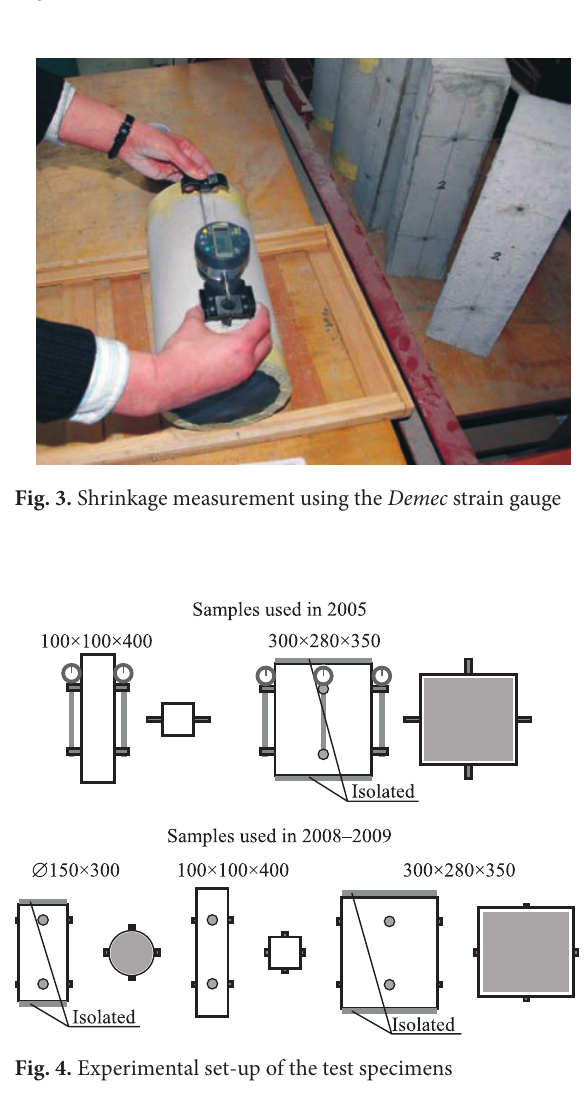
Table 2. The compressive strength of concrete, MPa Producing Mixture